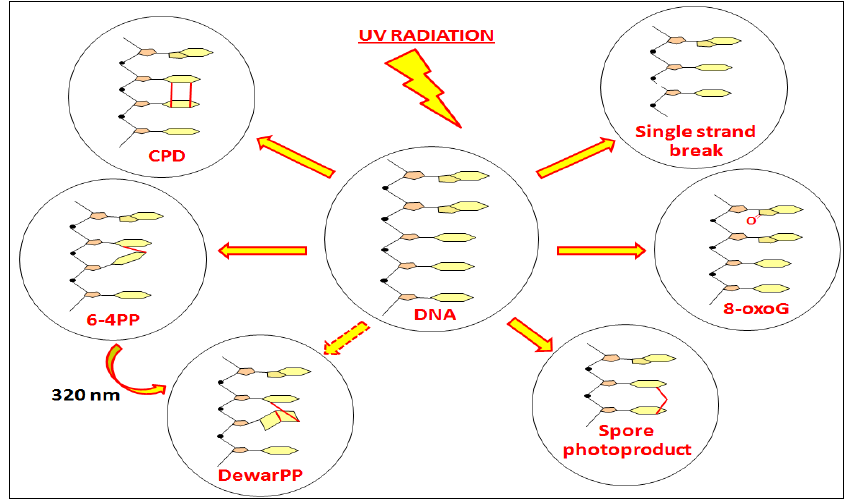
Figure 4. The main DNA lesions induced by UV light: CPD - cyclobutane pyrimidine dimer; 6-4PP - pyrimidine (6-4) pyrimidone photoproduct; DewarPP - Dewar valence isomer; Single strand breaks; 8-oxoG - 7, 8-dihydro-8-oxoguanine; Spore